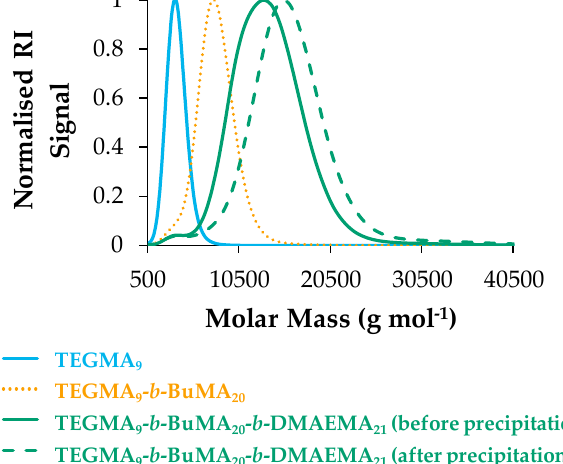
Figure 3. Gel permeation chromatography (GPC) traces of Polymer 1 (TEGMA 9 - b -BuMA 20 - b -DMAEMA 21 ) and its precursors. The TEGMA homopolymer (TEGMA 9 ), the diblock (TEGMA 9 - b -BuMA 20 ), and the triblock copolymer before precipitation are shown in blue solid, orange dotted and green solid lines, respectively. The triblock copolymer after precipitation is indicated by green dashed line.